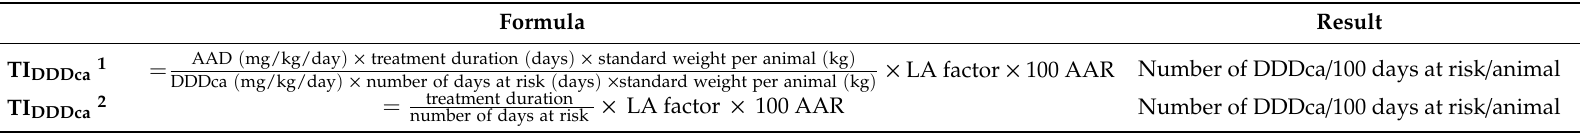
Table 3. Formulas to quantify antimicrobial usage using treatment incidence